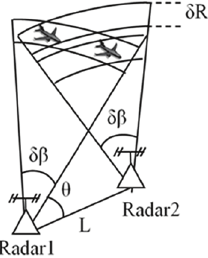
Fig. 2. Increasing the resolution in planar coordinates in a